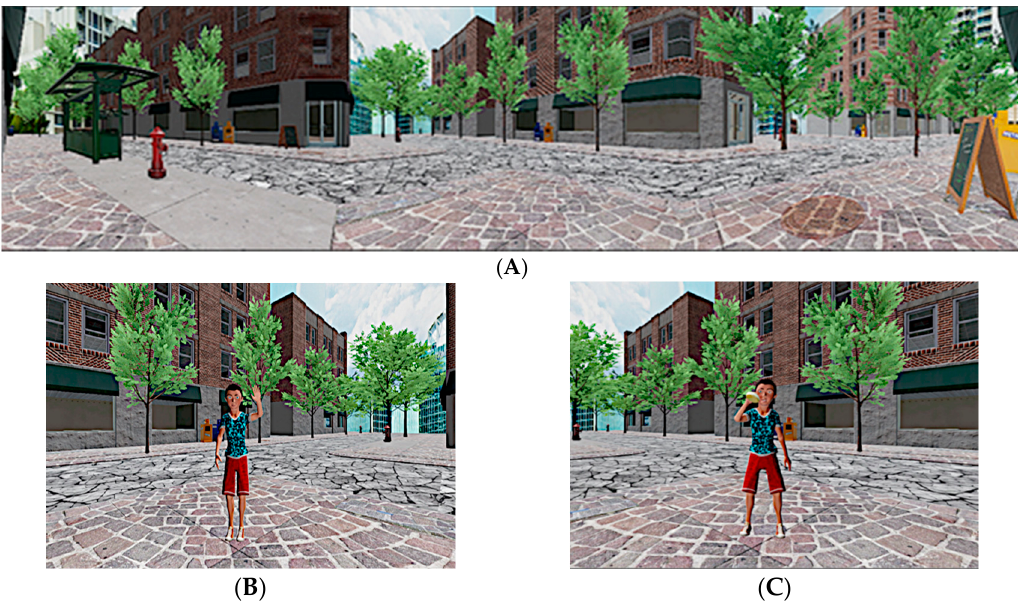
Figure 1. The virtual environment. ( A ) City street intersection; ( B ) visual (V) condition, boy’s avatar saying hello; ( C ) visual-auditory-olfactory (VAO) condition, boy’s avatar eating a muffin.